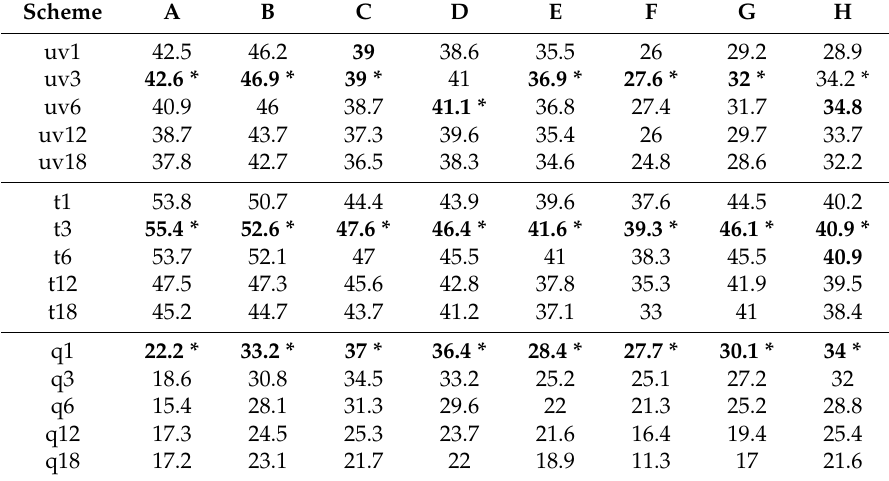
Table 7. Same as Table 3, except that the simulation results from 2009 were adopted (* denotes the optimum nudged level in